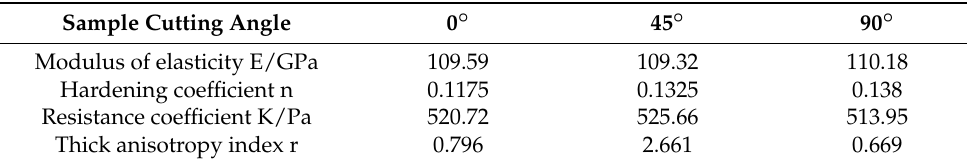
Figure 2. Stress strain diagram of the sample stretch. ( a ) Engineering stress–strain diagram. ( b ) True stress–strain diagram. Table 1. Synthesis of data from tensile tests.